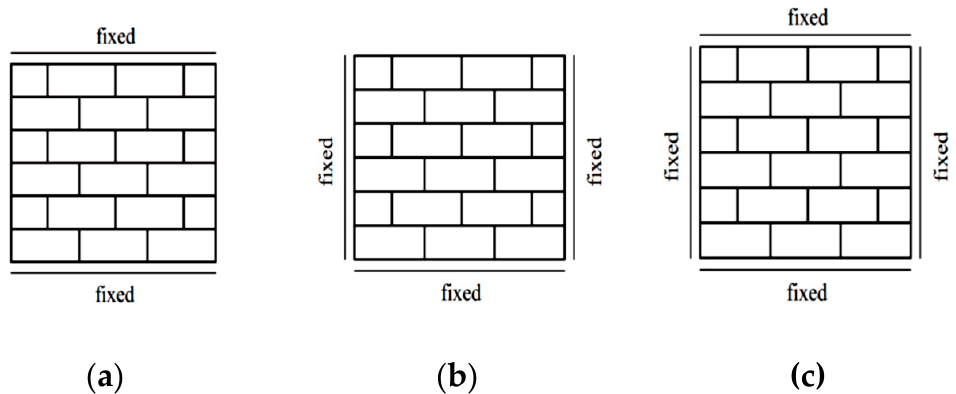
Figure 5. Specifications of the AAC wall and block model: ( a ) AAC block dimensions; ( b ) FE model of the wall; ( c ) assumed thickness of grout layer.